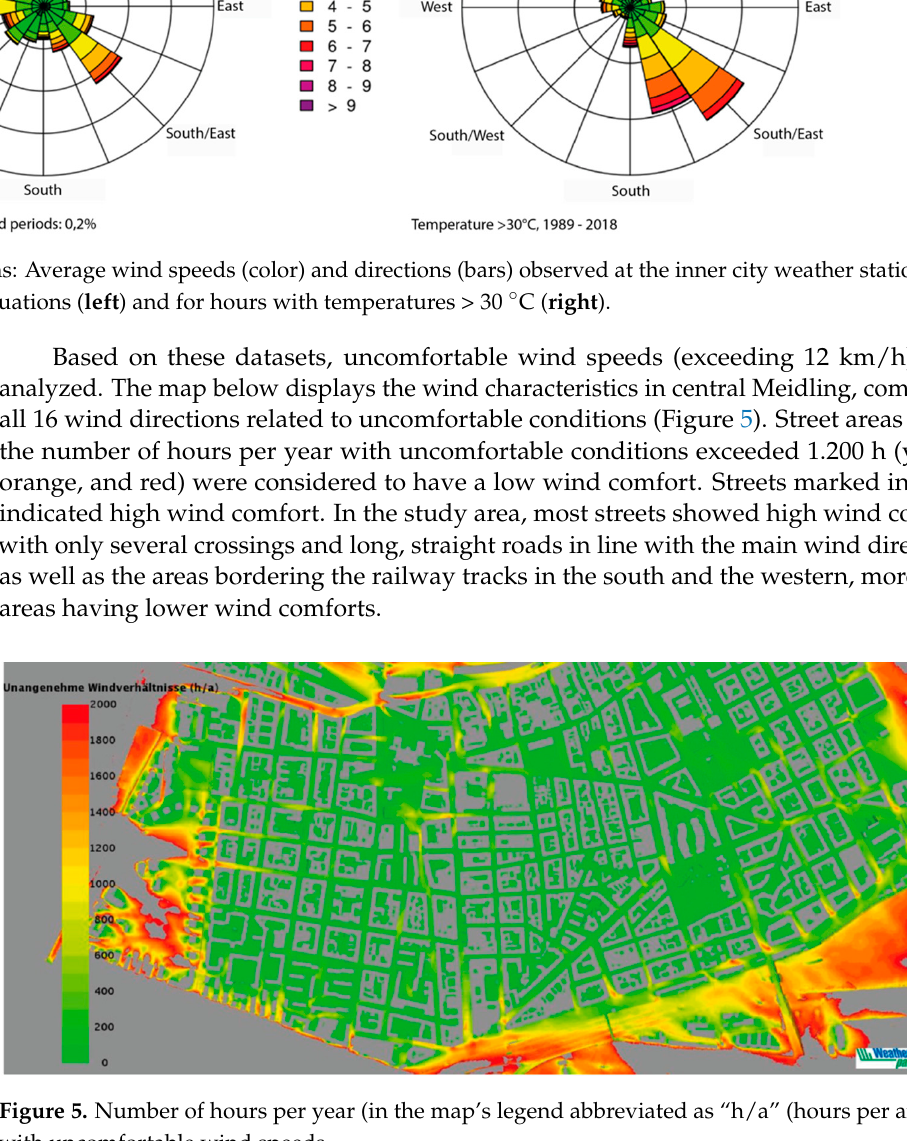
Figure 5. Number of hours per year (in the map’s legend abbreviated as “h/a” (hours per annum)) with uncomfortable wind speeds.